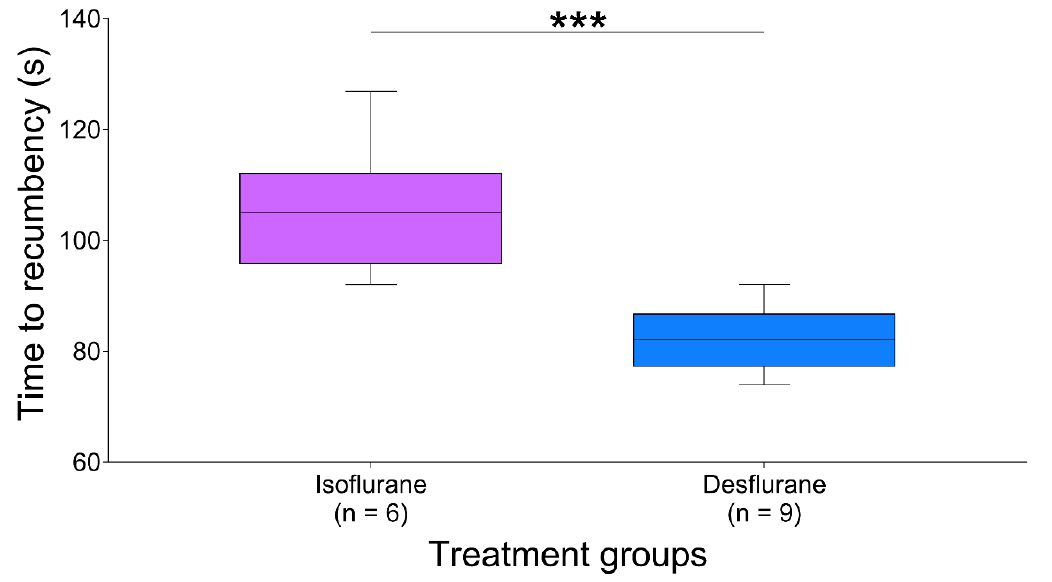
Figure 2. Time to recumbency. During initial exposure, 9 / 12 and 6 / 12 rats became recumbent after exposure to desflurane and isoflurane, respectively. Time to recumbency was shorter in rats exposed to desflurane than isoflurane. *** p < 0.001. Data are median (middle line in box), IQR (box limits) and 10–90 percentile (whiskers).